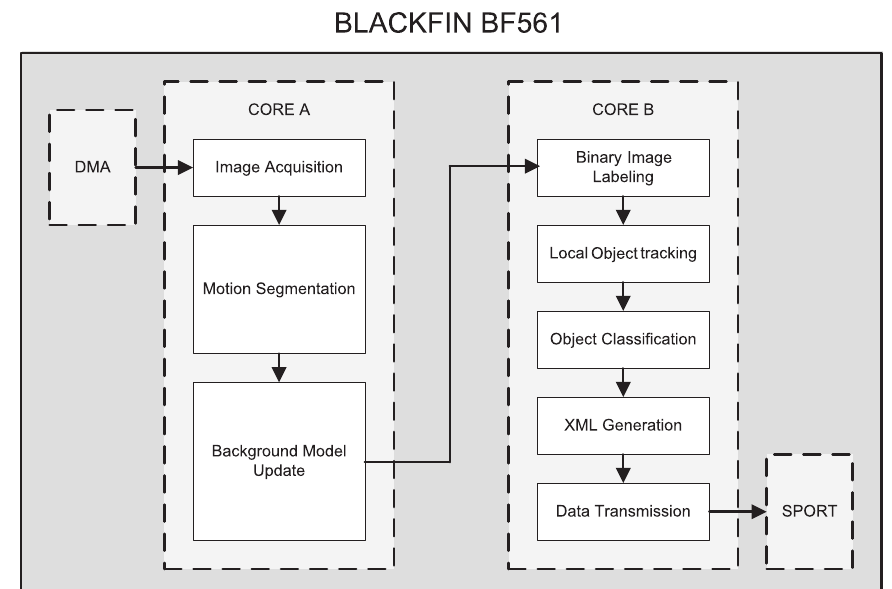
Figure 2. Video processing algorithm